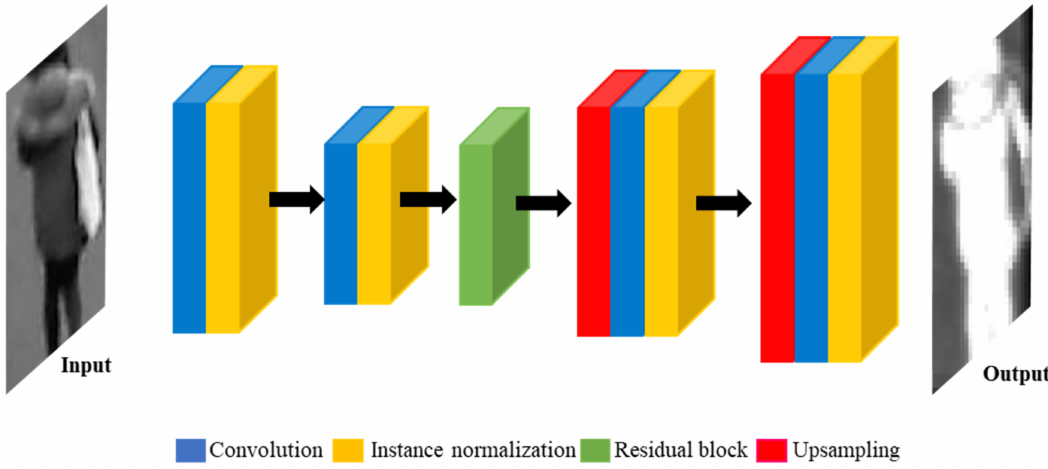
Figure 3. Description of the SI-AGAN attention module. Table 4. Architecture of the attention module. (Conv, DWConv, IN, and ReLU refer to convolution layer, depthwise separable convolution layer, instance normalization, and rectified linear unit,